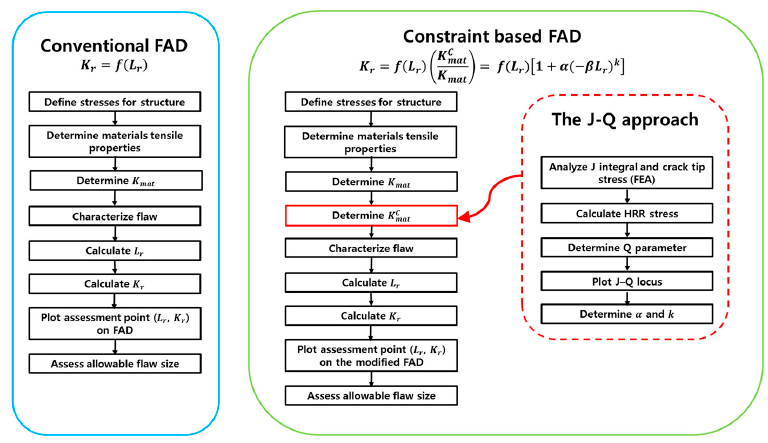
Figure 3. Comparison of the fracture assessment procedures between the conventional (BS 7910) and constraint-based (this study) approaches.